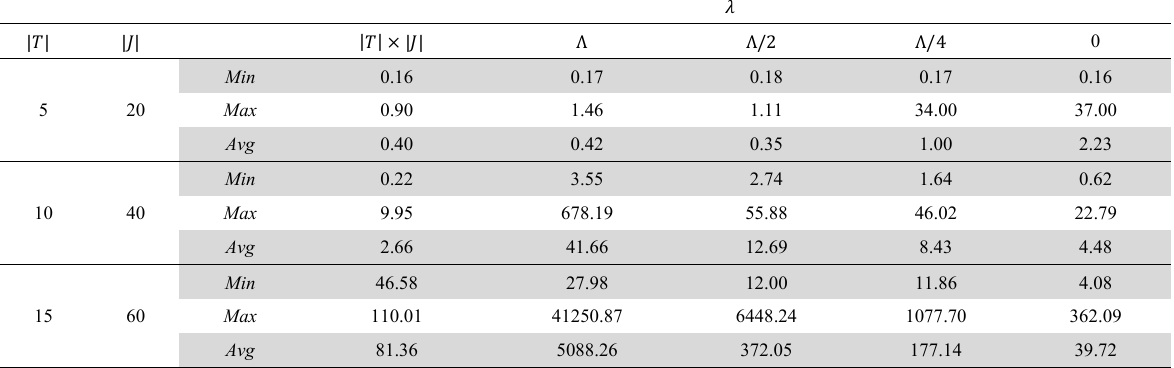
Results of Experiment 1: CPU times